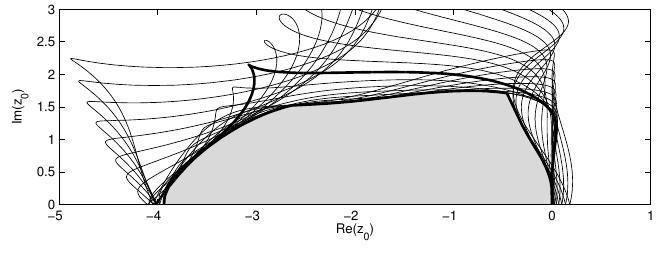
Figure 7. Stability regions S π/ 2 ,y , y = − 2 . 0 , 1 . 8 ,..., 2 . 0 (thin lines), S π/ 2 (shaded region), and S E (thick line) for β 10 = 6 . 679846861853708, β 20 = 6 . 776533083751429, β 30 = 8 . 549694721430665, β 21 = 0 . 726731199717484, β 31 = 0 . 052947612675072, and β 32 = 0 .